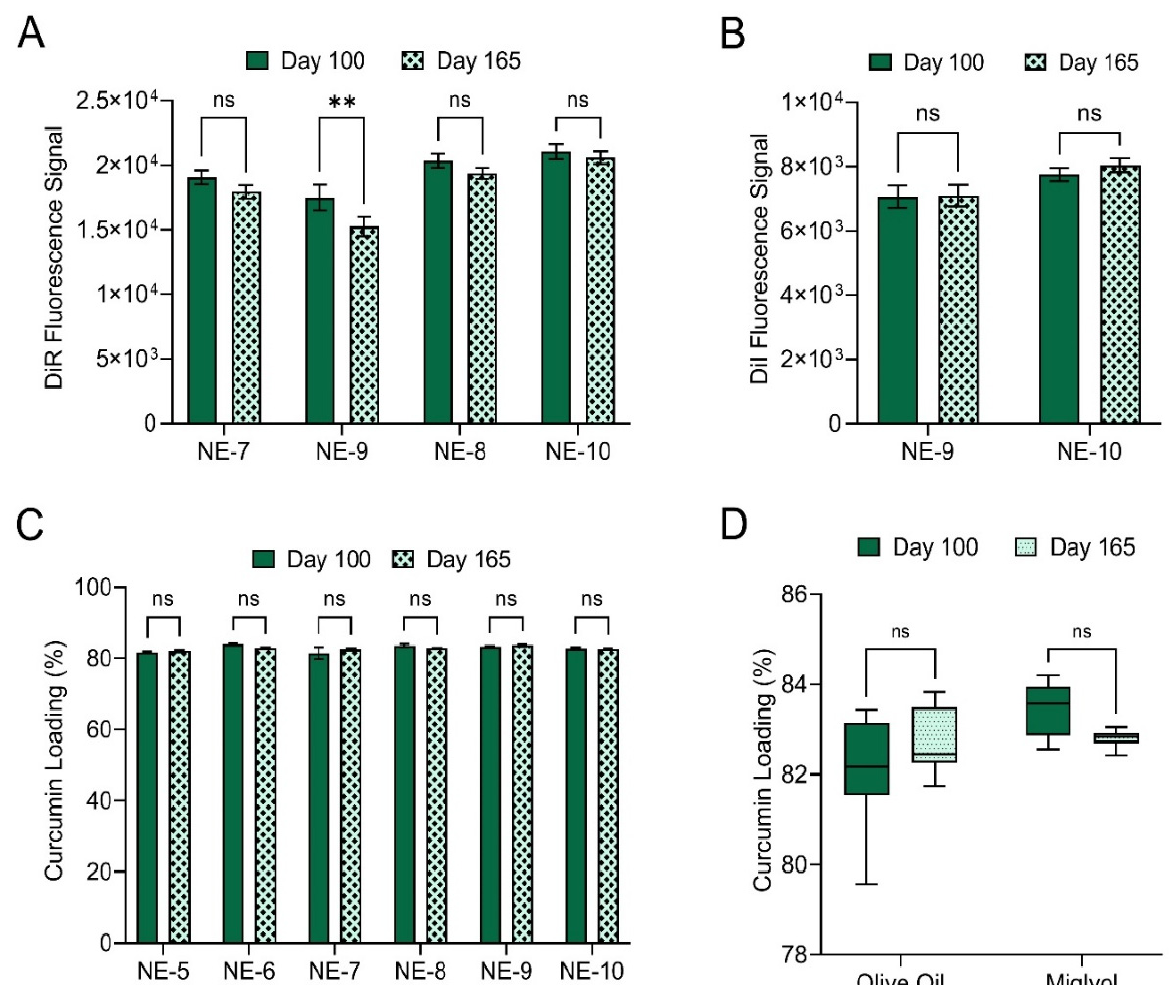
Figure 9. Nanoemulsion fluorescence and curcumin loading stability upon 65 days storage at 4 °C. ( A , B ) Fluorescence signals of stage 2 nanoemulsions containing ( A ) DiR or ( B ) DiI were measured on days 100 and 165 post manufacture. ( C , D ) Curcumin loading of stage 2 nanoemulsions on days 100 and 165 post manufacture. Curcumin loading values are shown for ( C ) each nanoemulsion individually and ( D ) as the average of three nanoemulsions grouped by hydrocarbon oil. ** p -value < 0.01; ns, no significance.